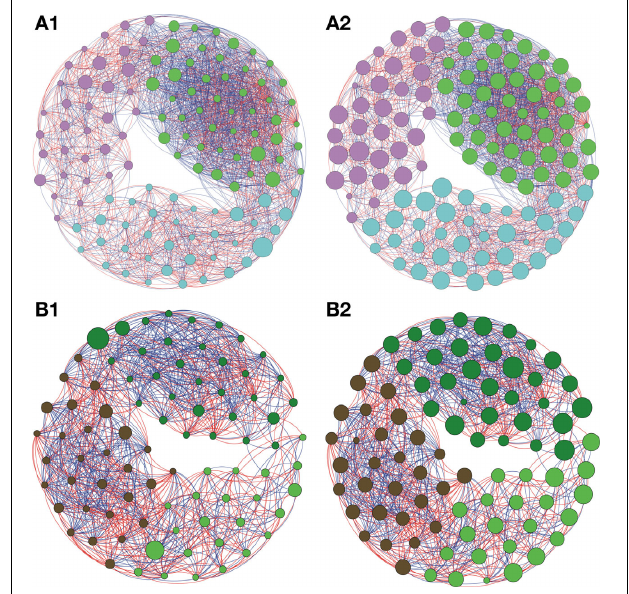
FIGURE 4 | Network interactions of soil bacterial genus found in Natural forest (A1, A2) and in the Pasture (B1, B2) on Cerrado biome. A connection stands for a strong Pearson’s correlation ( p ≥ 0 . 9 and P -value ≤ 0.05). Each circle (usually called node) represents a bacterial genus and the sizes of the circles are proportional to the value of betweenness centrality in (A1) and (B1) . In (A2) and (B2) the sizes of the circles are proportional to value of closeness centrality. Lines connecting two bacterial genera represent the interactions between them. Blue lines represent the positive significant correlations and red lines represent a negative significant correlation. The colors of the circles represent the bacterial modules. For clarity, the OTU’s identity was omitted. Detailed networks containing the identity of each node can be observed in the Supplementary Figures S1–S5 and Supplementary Table